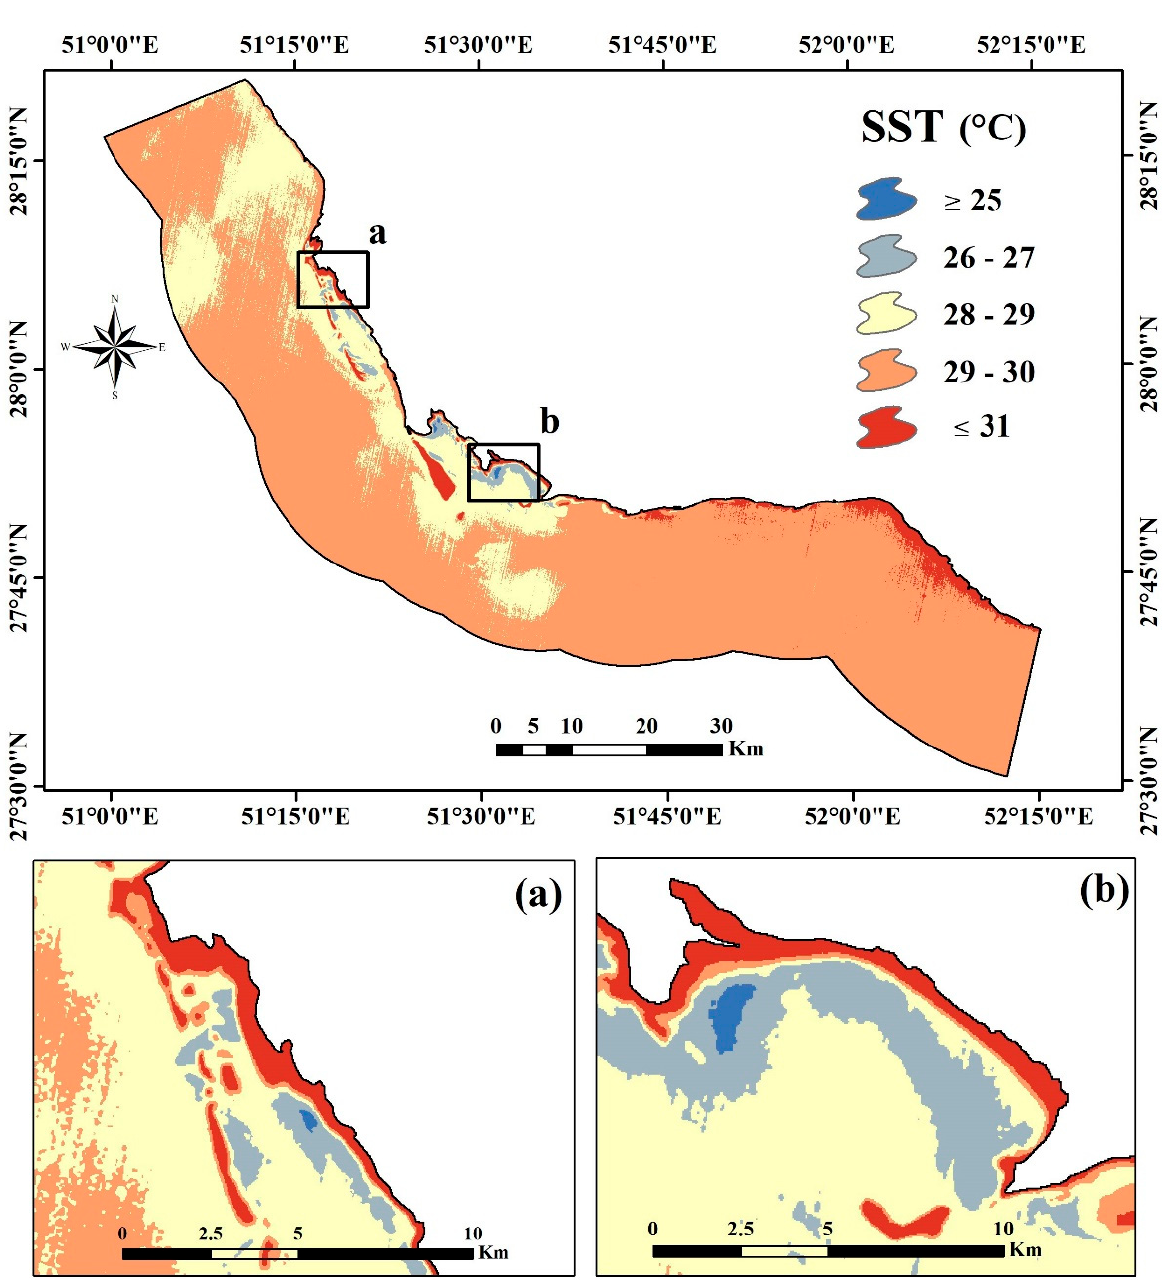
Figure 3. An example of the SST map derived from Landsat ETM+ TIR imagery acquired on 23 August 2015 (9:45 a.m. local time): ( a ) Shif-Hendijan and ( b ) Naiband #1